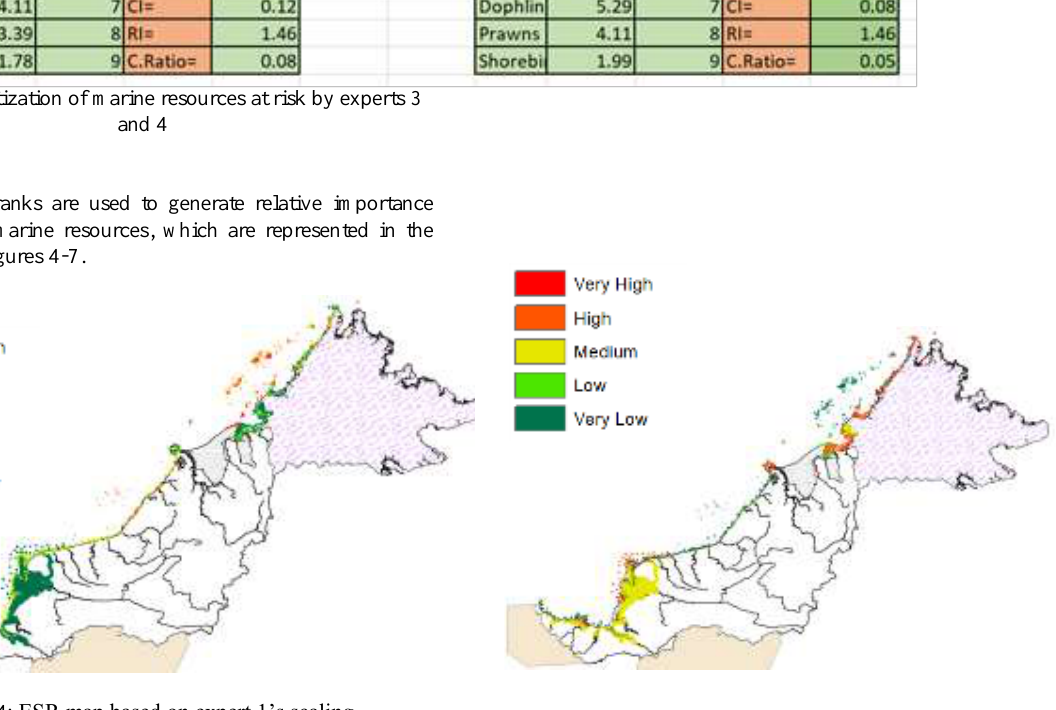
Figure 5: ESR map based on expert 2’s